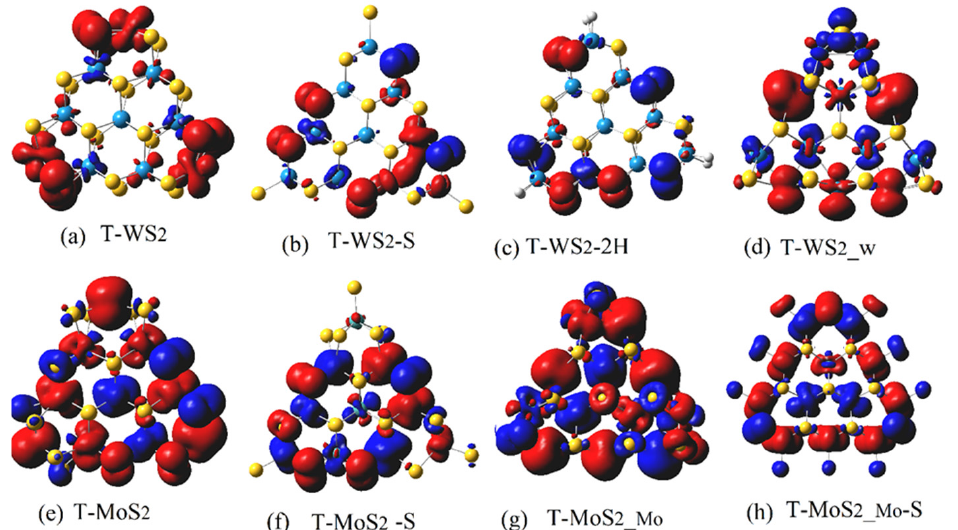
Figure 2. Spin density distribution of spin up (red) and spin down (blue) on WS 2 and MoS 2 quantum dots before and after double hydrogenation as labeled below each subfigure, the isovalue of the spin density is 0.004 Å − 3 .